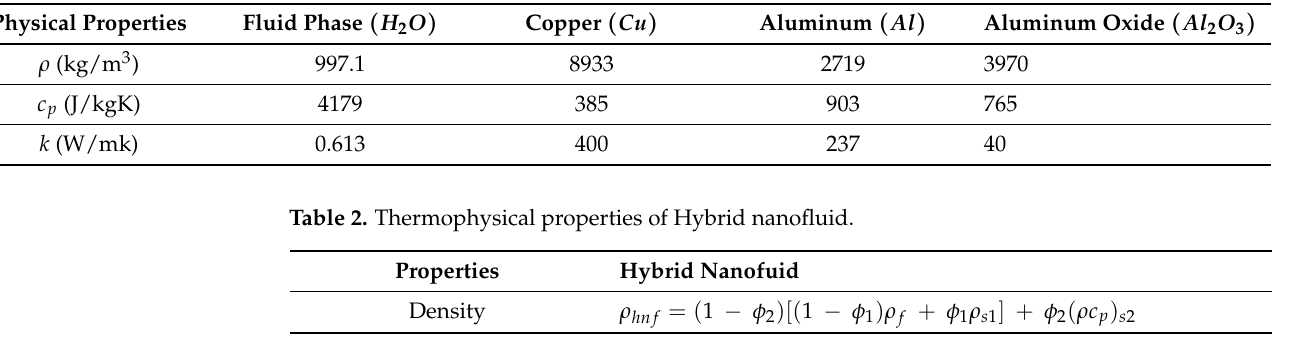
Table 1. The thermal properties of H 2 O , Cu , Al and Al 2 O 3 .